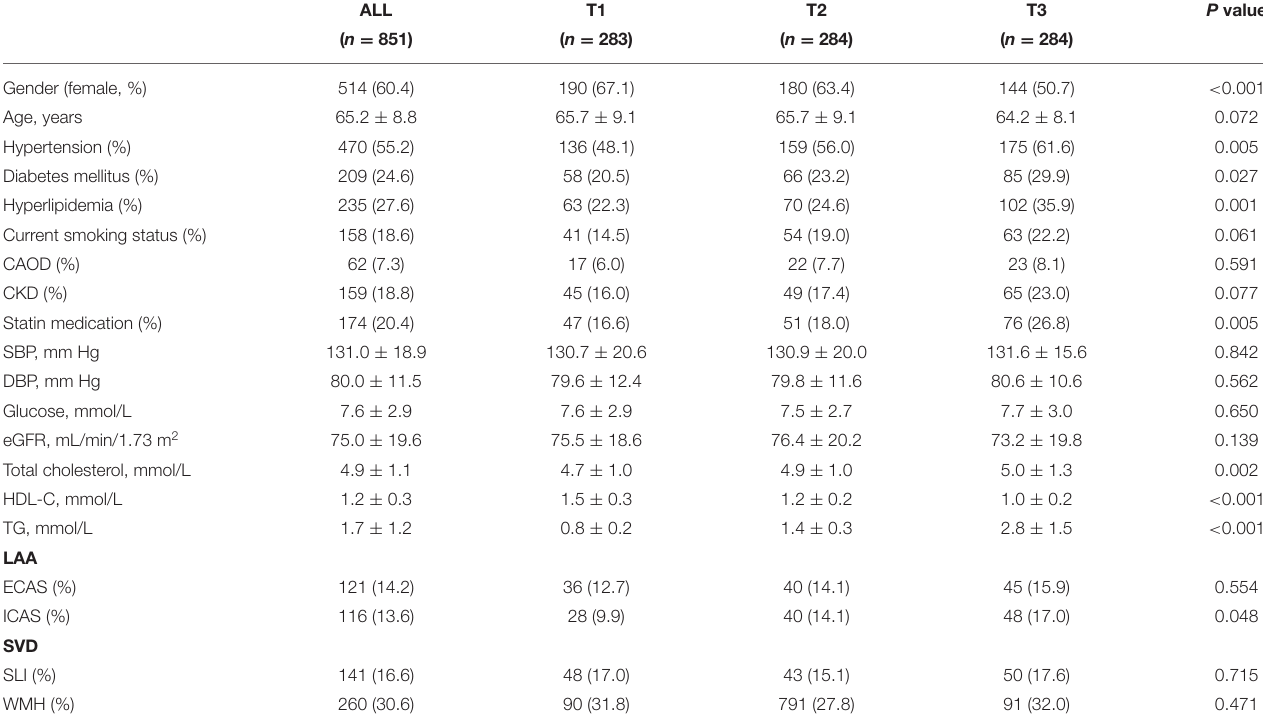
TABLE 1 | Clinical characteristics of subjects based on THR tertiles. ALL T1 T2 T3